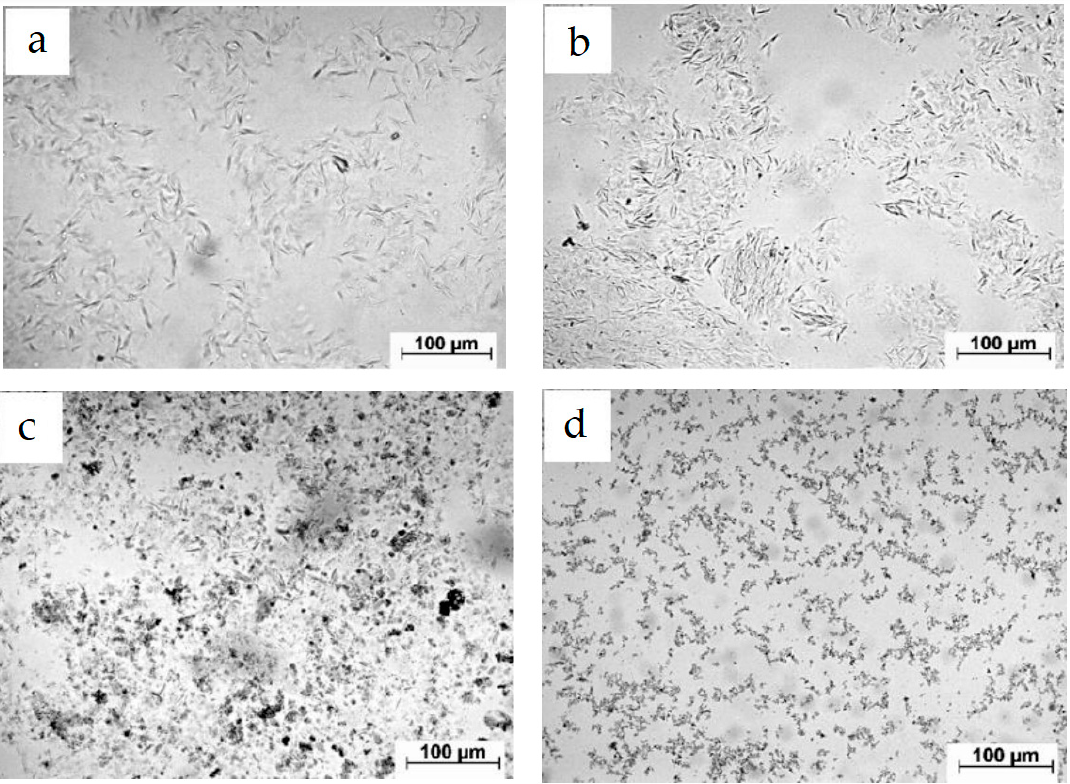
Figure 5. Micrograph of the structure formation of highly paraffinic oils during ultrasonic treatment: ( a )—oil before treatment, ( b )—oil after 10 min of treatment, ( c )—oil after 10 min of treatment and the introduction of 3% resins, ( d )—oil after 10 min of treatment and the introduction of 10% resins.